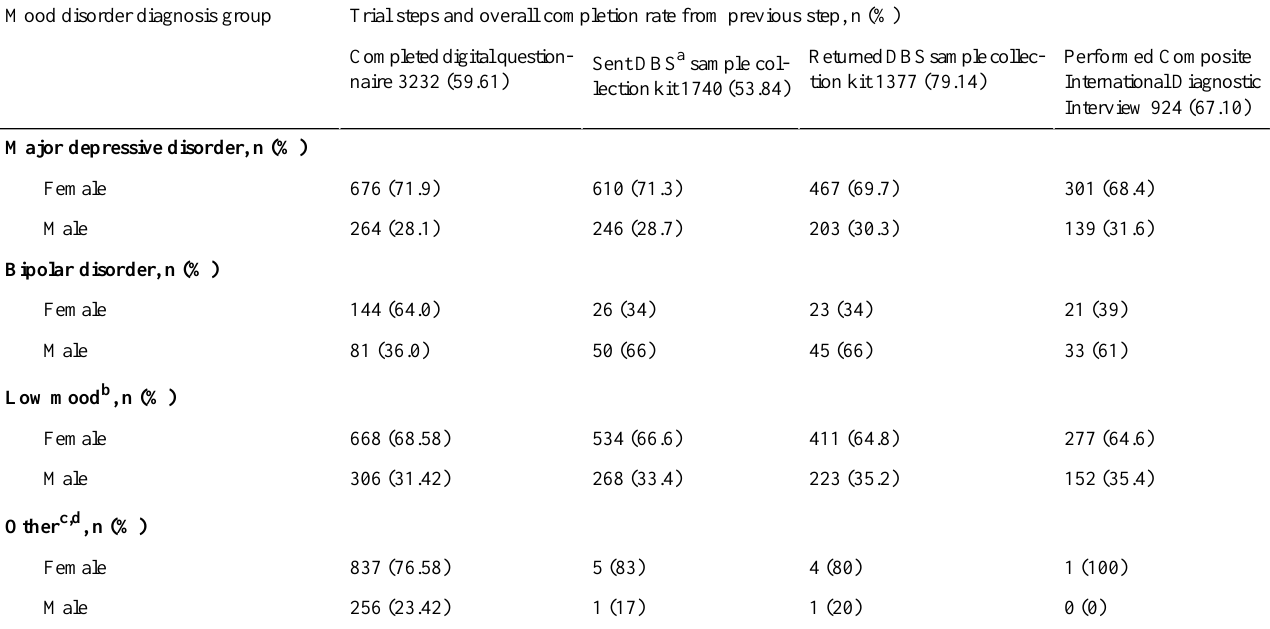
Table 2. Delta Trial participant progress, grouped by baseline mood disorder diagnosis group (N=5422). Trial steps and overall completion rate from previous step, n (%)Mood disorder diagnosis